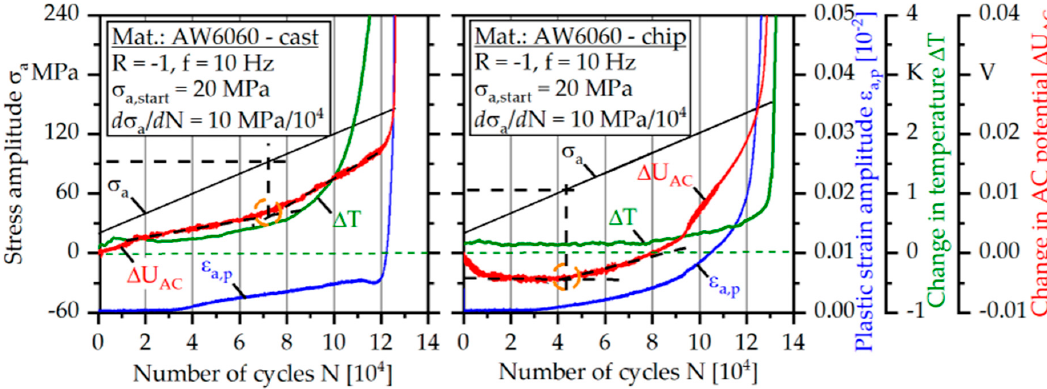
Figure 6. Volume reconstruction of chip-based specimen tested in a tensile test: ( a ) three-dimensional representation, ( b ) cross-sectional view parallel to the load direction, ( c ) cross-sectional view perpendicular to the load direction.